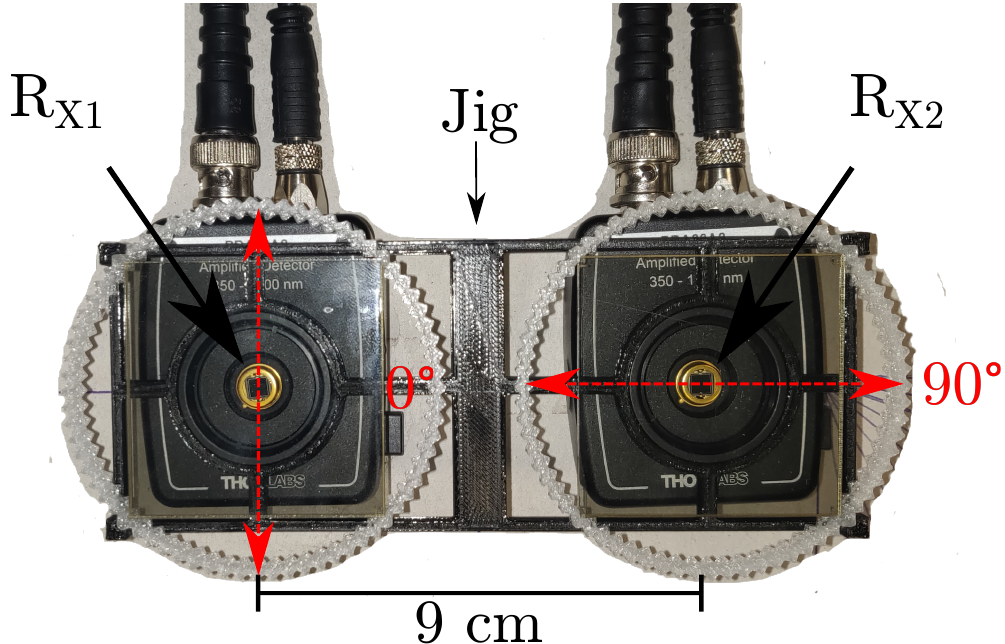
Figure 5. Setup A: two PDA36A2 receivers are equipped with mutually orthogonal polarizers on 5 ◦ increment measurement jig for θ = 0 ◦ [17].